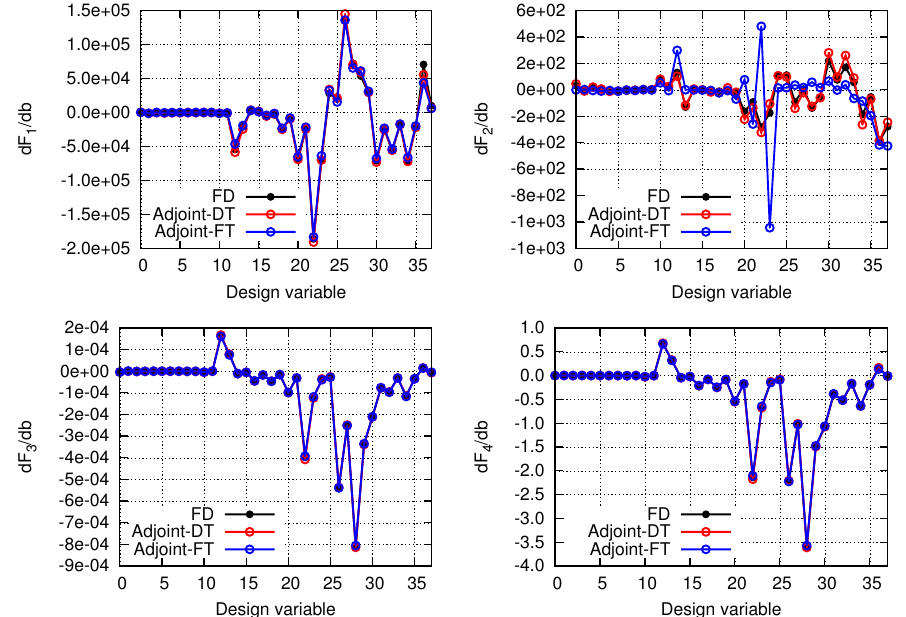
Figure 5. Verification of the sensitivity derivatives computed by the adjoint method with the differ- entiated turbulence (DT) model and with the frozen turbulence (FT) assumption for F 1 ( top left ), F 2 ( top right ), F 3 ( bottom left ), and F 4 ( bottom right ). Finite differences are used as the reference